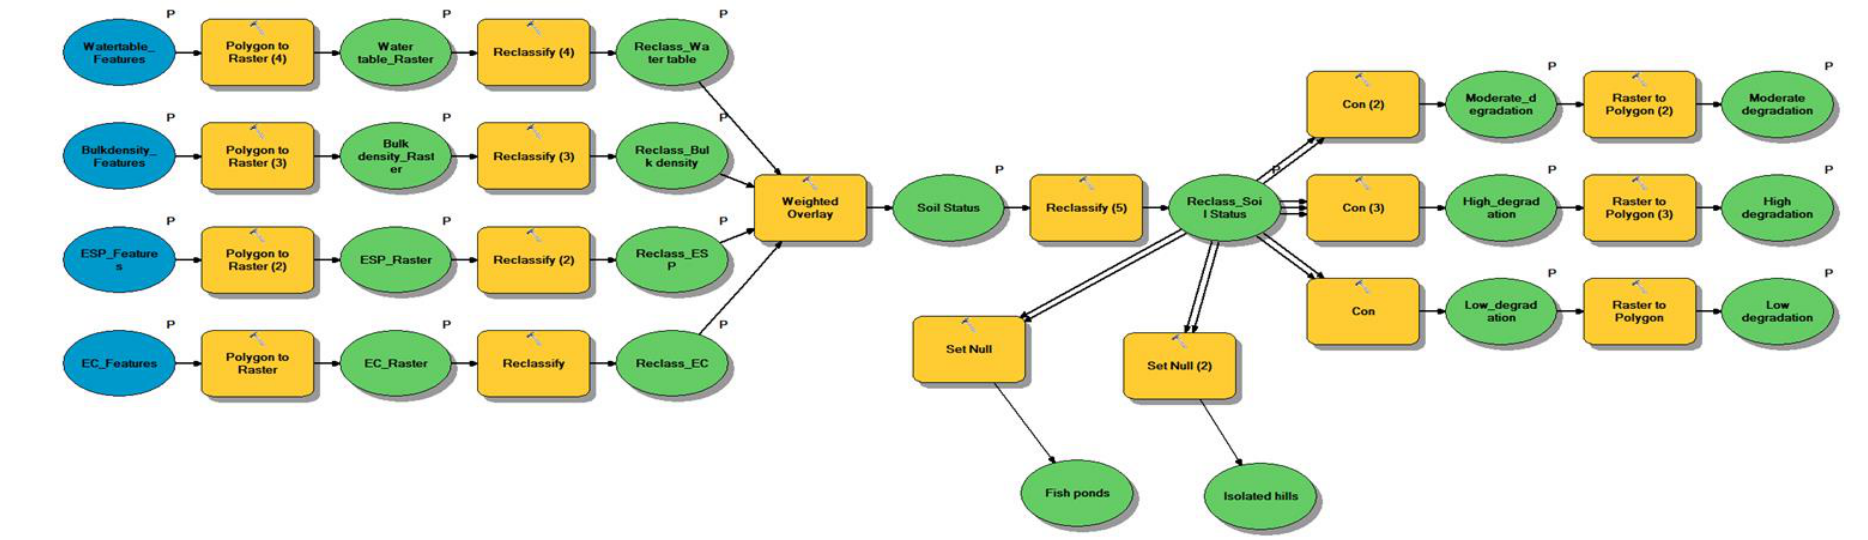
Figure 3. Flowchart of the designed soil degradation model.